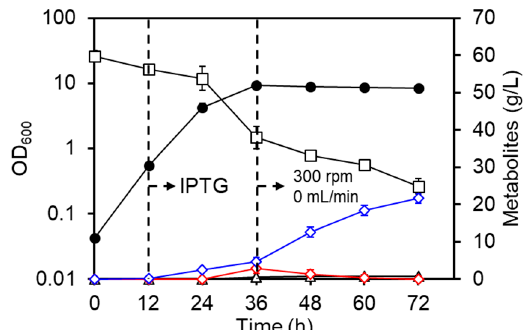
Figure 5. Culture profiles of the LAC strain under the combined conditions. IPTG was added to the pre-culture at 0 h and to the main culture at 12 h. The values of the aeration parameters were changed at 36 h from 1800 rpm and 150 mL min − 1 to 300 rpm and 0 mL min − 1 , respectively. Symbols: circles, OD 600 ; squares, glucose; triangles, acetate; red diamonds, pyruvate; blue diamonds, d -lactate. Data shown are the mean ± SD ( n = 3).